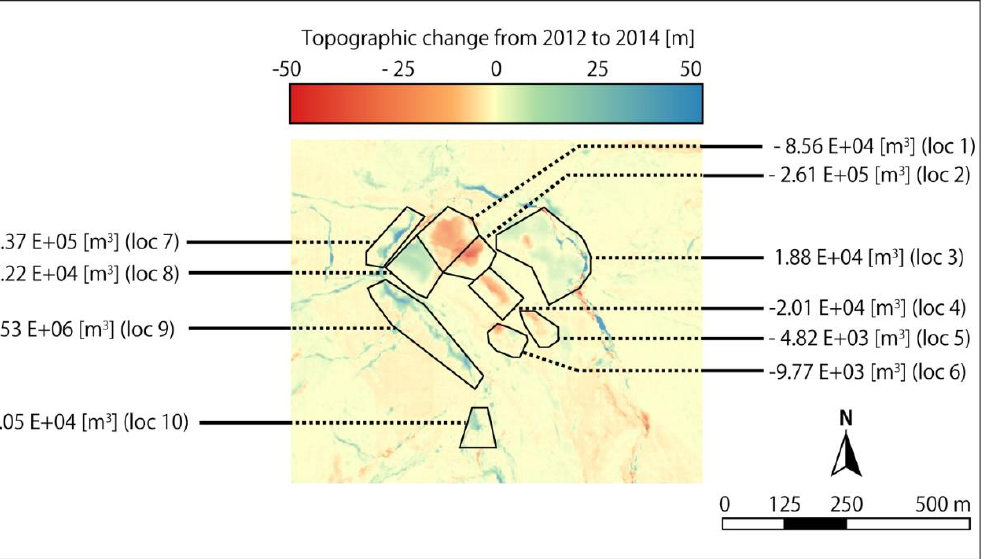
Figure 4. Topographic change from 2012 to 2014. These data show the vents opening and the “split in two” of the dome, as well as the areas between the crater rim and the dome, where the topography increased, arguably due to exploded material deposition. These changes emphasize the changes that are >2.5 m (i.e., in blue on the map), valued above the overall RMSE and the RMSE of the outside structure. This procedure may erase some of the minor variations, but it is aimed at eliminating the false positives from the dataset.